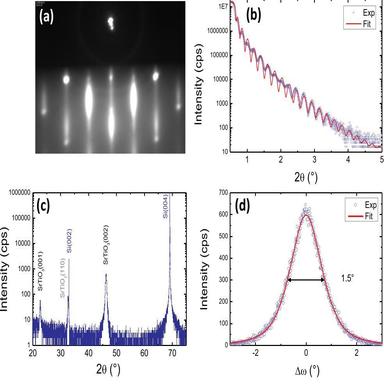
Structural characterization of the STO/Si substrate. (a) RHEED pattern recorded along the 〈100〉STO direction at the end of the growth, (b) XRR, (c) XRD θ/2θ scan, and (d) XRD ω-scan around the (002) reflection of STO.